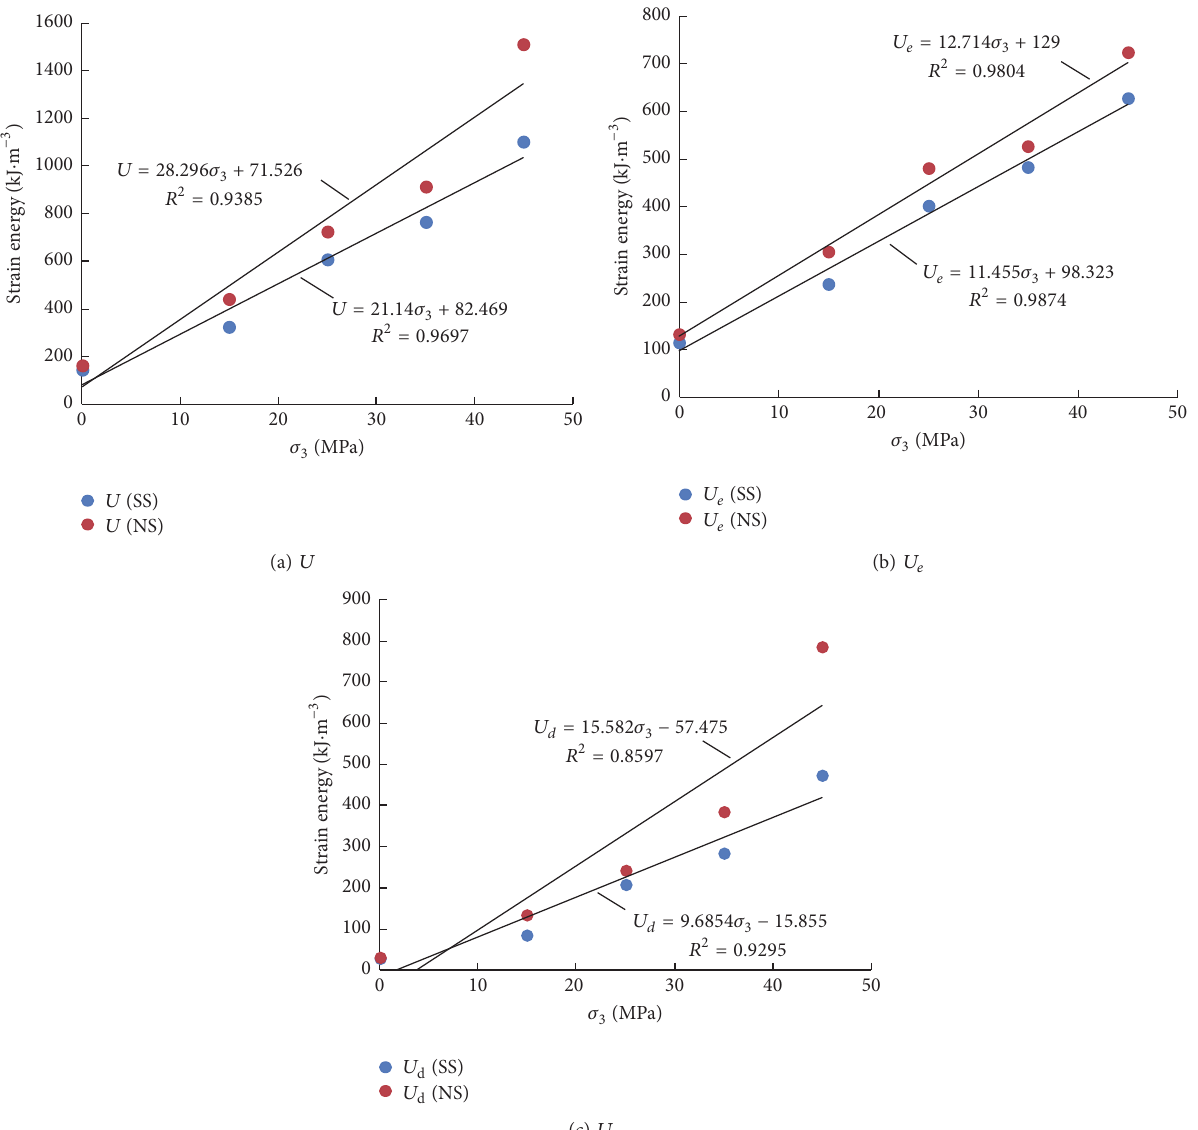
Figure 10: Relationships between the strain energy at the peak point and the confining pressure under natural and saturated states.